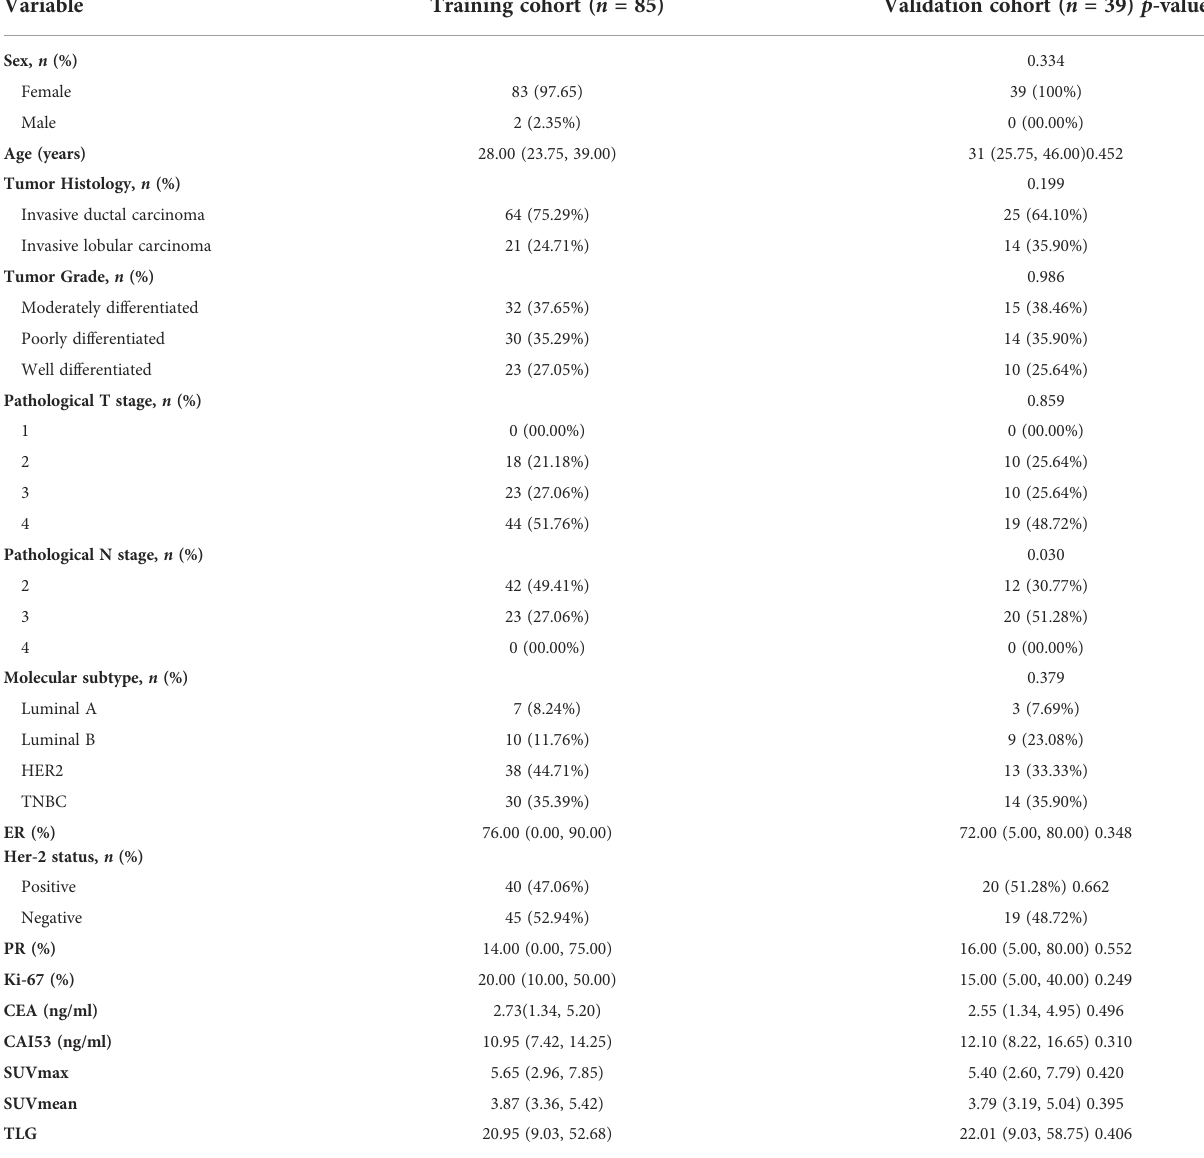
TABLE 1 Demographic information and clinicopathological characteristics of selected patients with